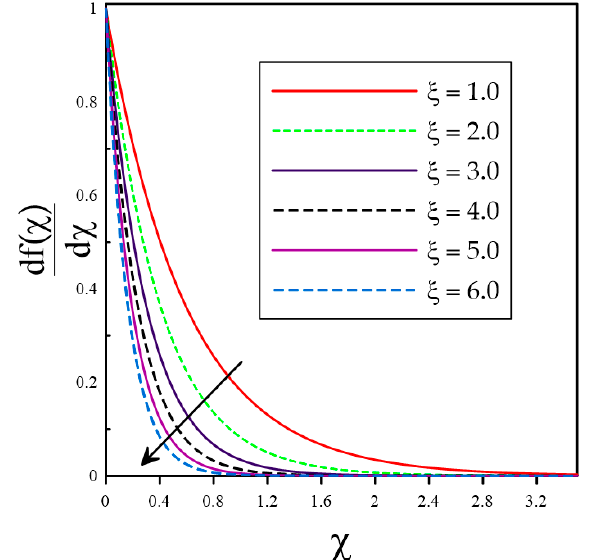
Figure 2. Velocity profile against the various values of withdrawal.